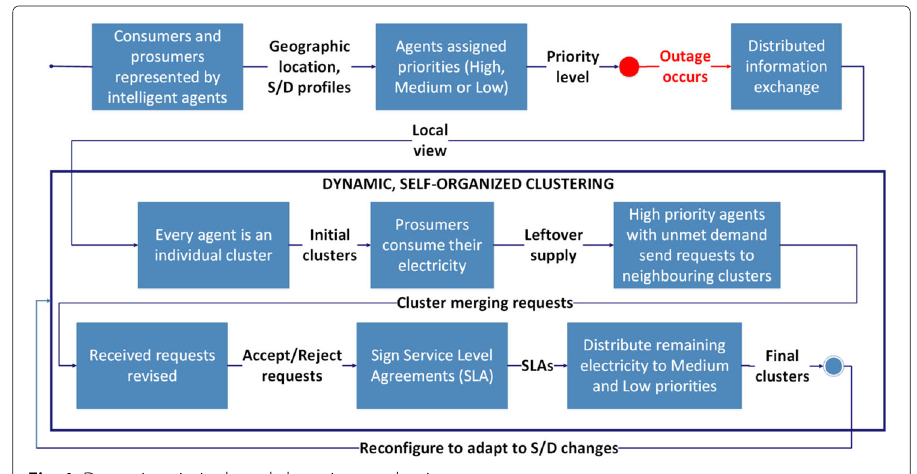
Fig. 1 Dynamic, priority-based clustering